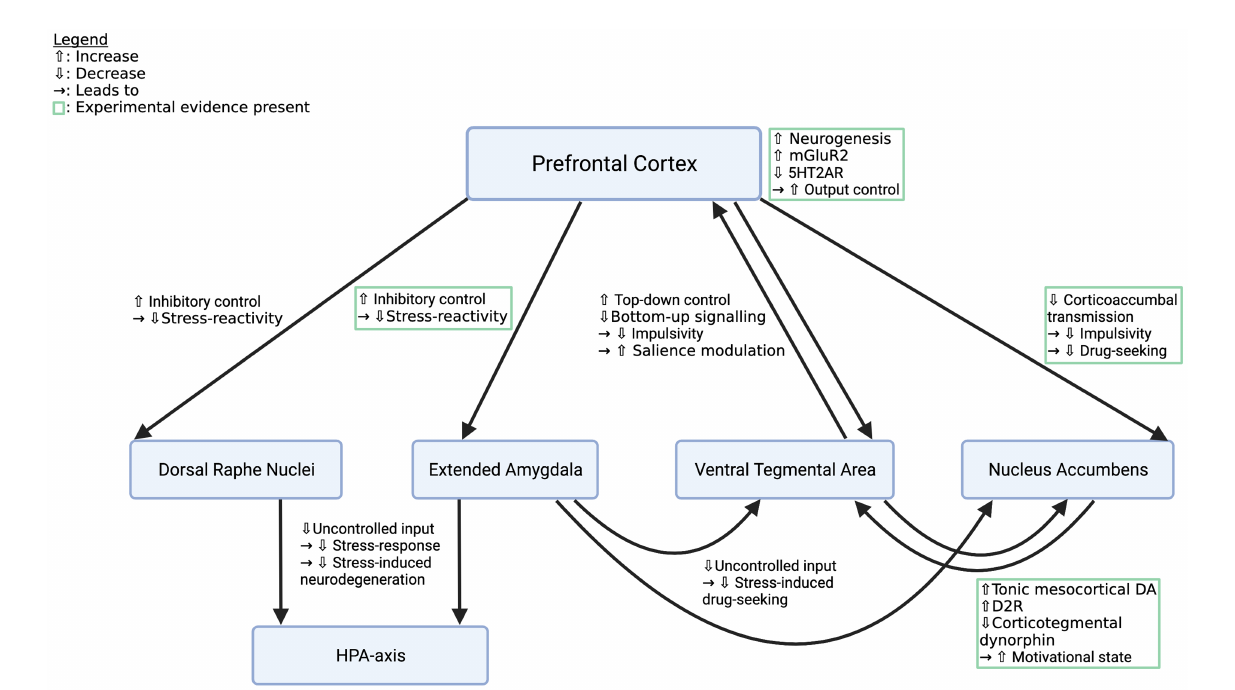
FIGURE 1 Effects of psychedelics on key pathways in the addicted brain. Depicted are crucial pathways that contribute to the behavioral and affective symptoms of SUDs and descriptions of how psychedelics supposedly alter their function to restore a healthy phenotype. Mechanisms listed in green boxes are backed up by experimental evidence, the other ones are deduced from knowledge about addiction circuitry and the effects of psychedelics. However, all pathways deserve closer examination. mGluR2, metabotropic glutamate receptor subtype 2; 5HT2AR, 5-hydroxy tryptamine 2a receptor; HPA-axis, hypothalamic–pituitary–adrenal axis. Created with